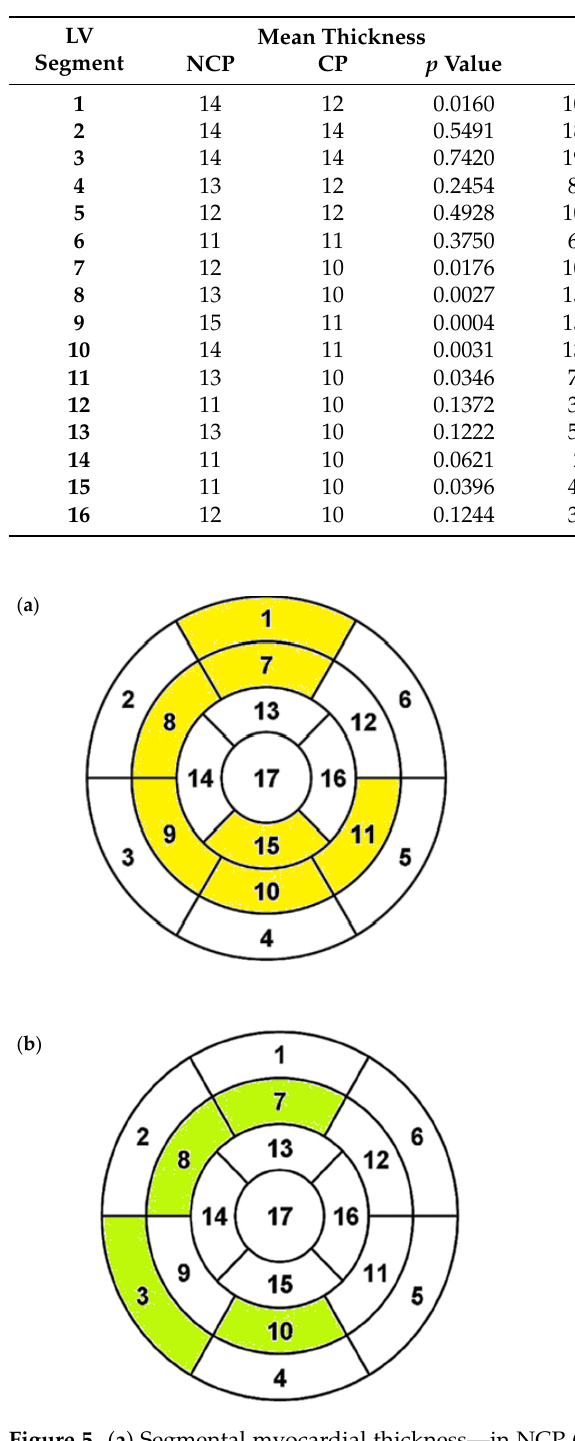
Table 2. Left ventricular segmental mean myocardial thickness and segmental distribution of late enhancement areas—comparison between the nonclassic and classic phenotype.